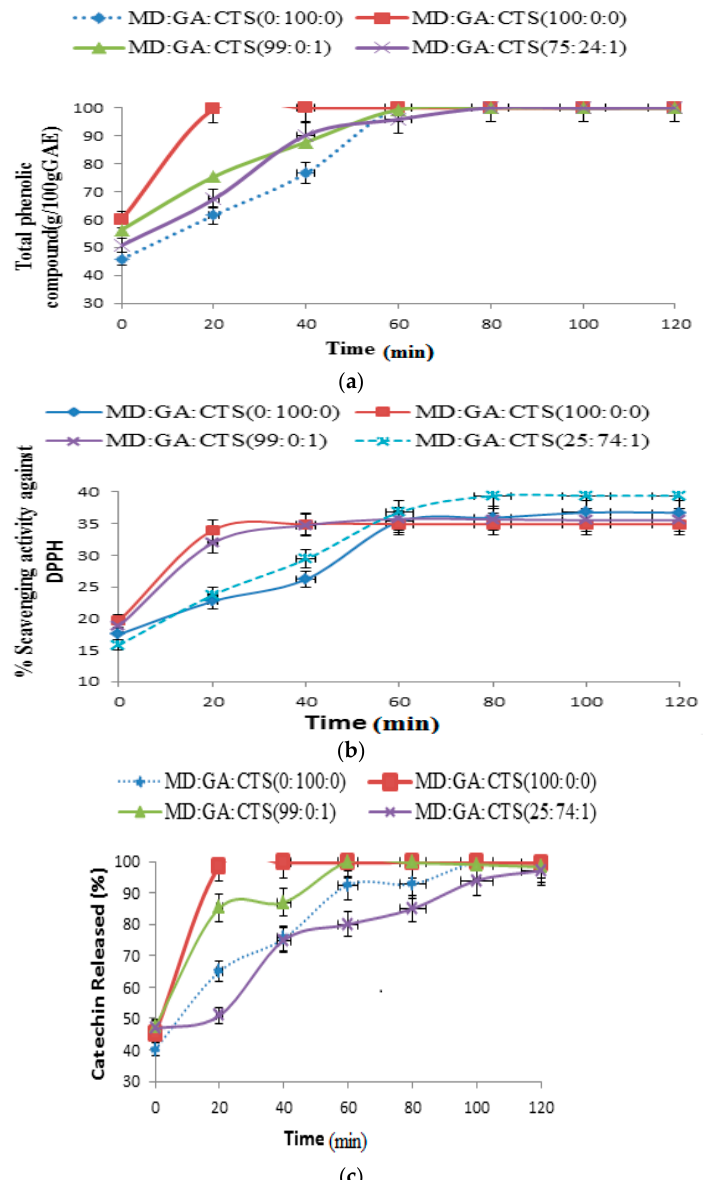
Figure 6 In vitro release profiles ( a ) total phenolic content (TPC); ( b ) DPPH scavenging activity; ( c ) TC from microparticles in simulated intestinal fluid (pH 7.4) at 37 °C for 120 min. The values are represented as the means ± SD. (MD—maltodextrin, GA—gum arabic, CTS—chitosan). represented as the means ˘ SD. (MD—maltodextrin, GA—gum arabic,